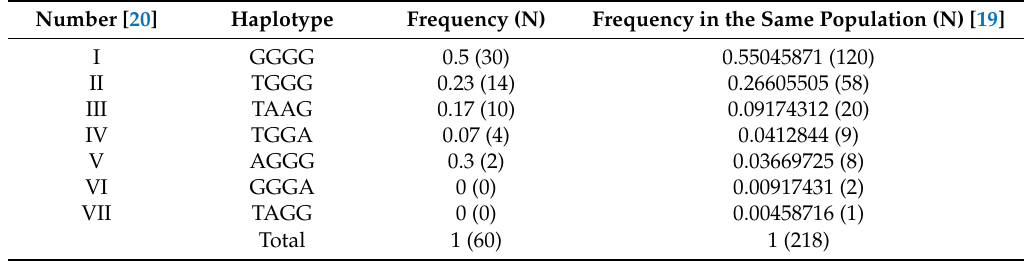
Table 2. Haplotypes and frequencies of the gene A3Z3 found in the studied population of FIV-positive cats in Porto Alegre city, and comparison of frequencies with the previous study in the same